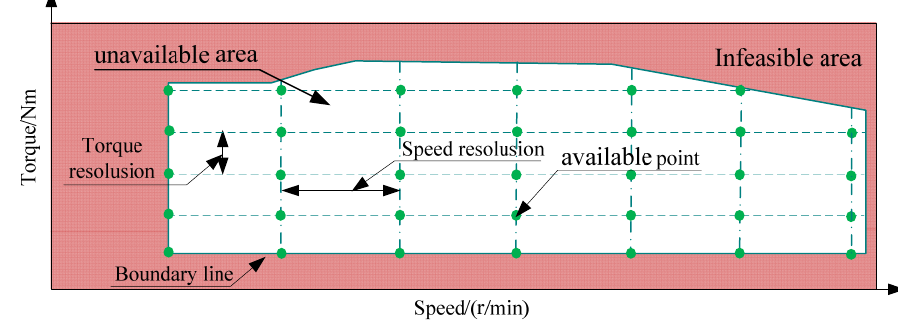
Figure 2. Discretization of the control